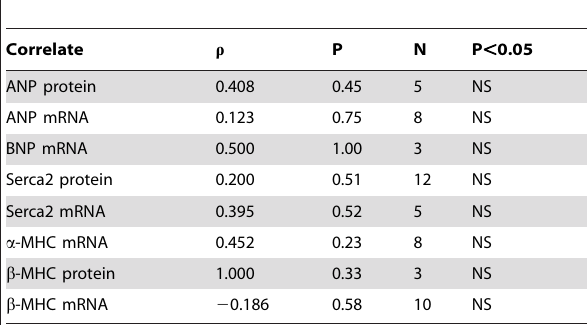
Table 8. Spearman correlations of fetal genes with the HW:BW index in rodent models of type 1 diabetes.